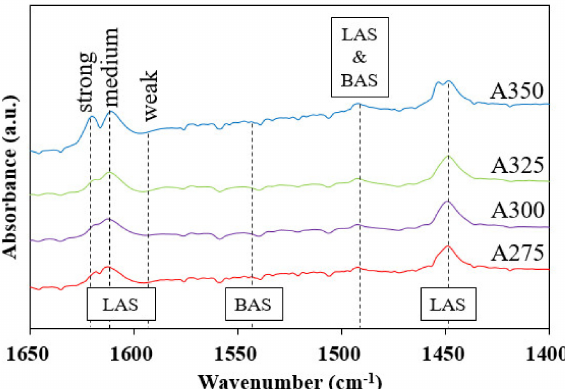
Figure 6. Pyridine-FTIR spectra of the synthesized alumina catalysts A275, A300, A325, and